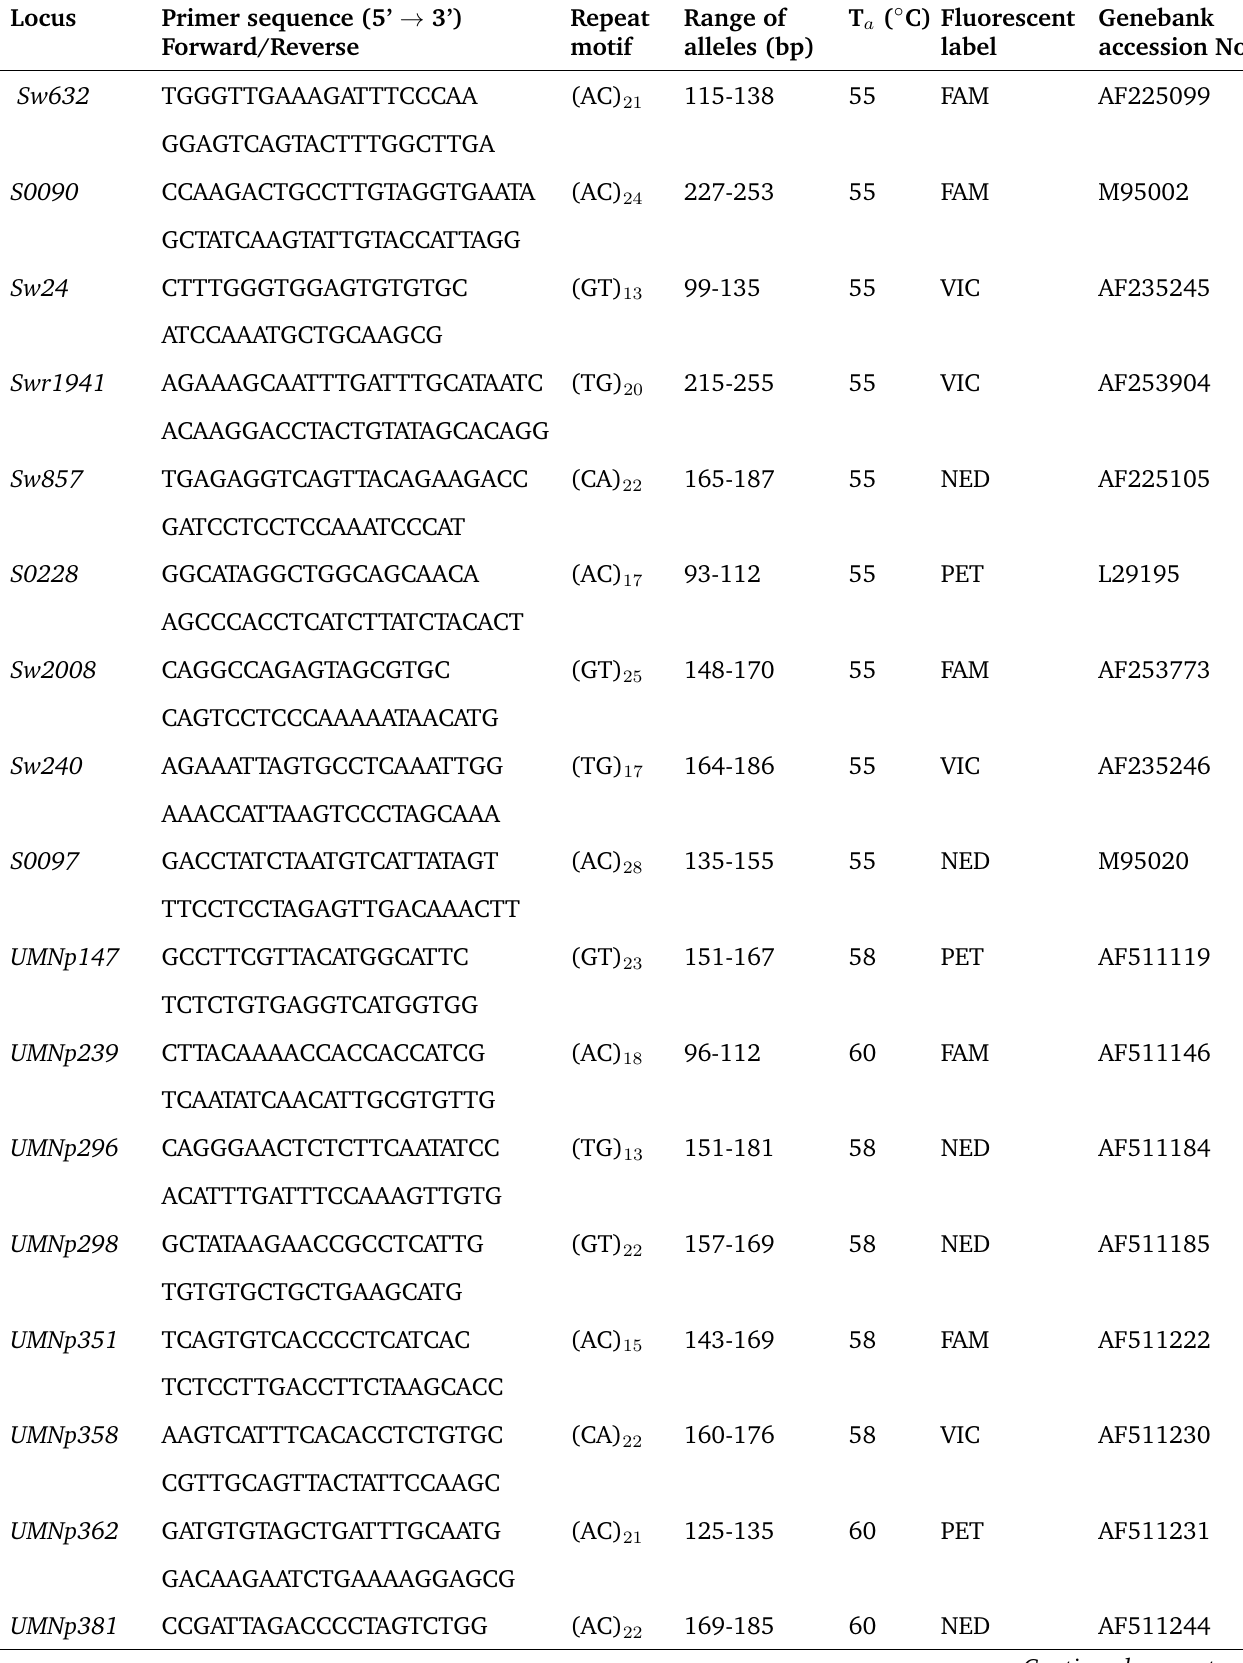
Table 1. Characteristics of 32 microsatellite markers selected. T a = annealing temperature